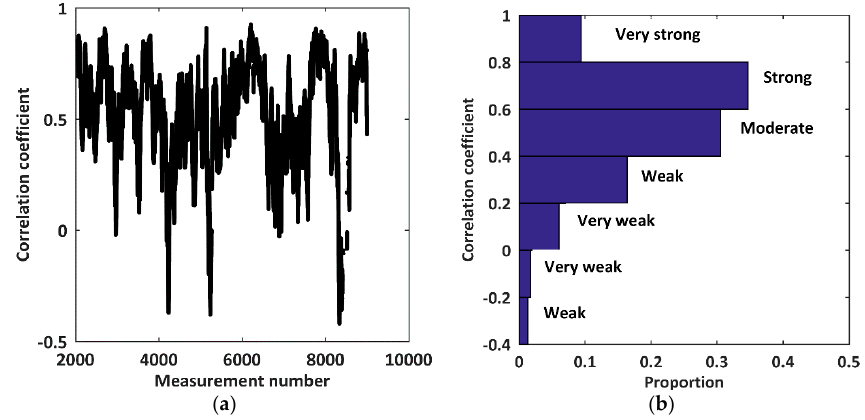
Figure 7. ( a ) The correlation coefficients of CHPs derived from Tomoradar and LiDAR; and ( b ) the proportions of correlation coefficients to 6766 measurements based on the strength of correlation. If a correlation coefficient is greater than zero, it is a positive correlation. On the contrary, it is a negative relationship.